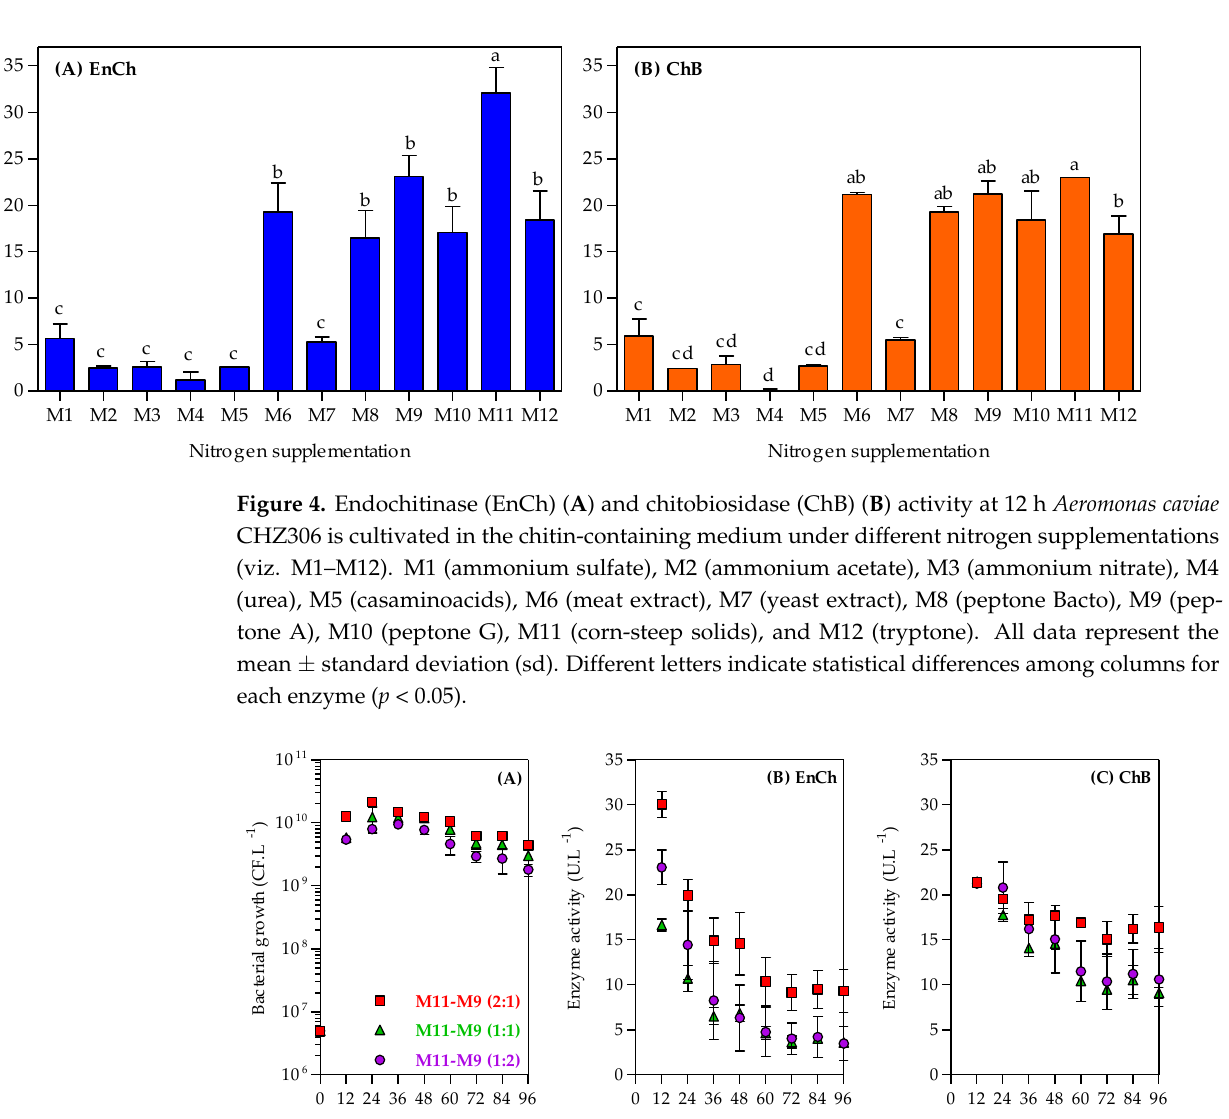
Figure 5. Time-course kinetics profiles of bacterial growth ( A ), endochitinase (EnCh) activity ( B ), and chitobiosidase (ChB) activity ( C ) of Aeromonas caviae CHZ306 in the chitin-containing medium under corn-steep solids (M11) and peptone A (M9) mixtures at ratios of 1:1 (green triangles), 1:2 (purple circles), and 2:1 (red squares). All data represent the mean ± standard deviation (sd).